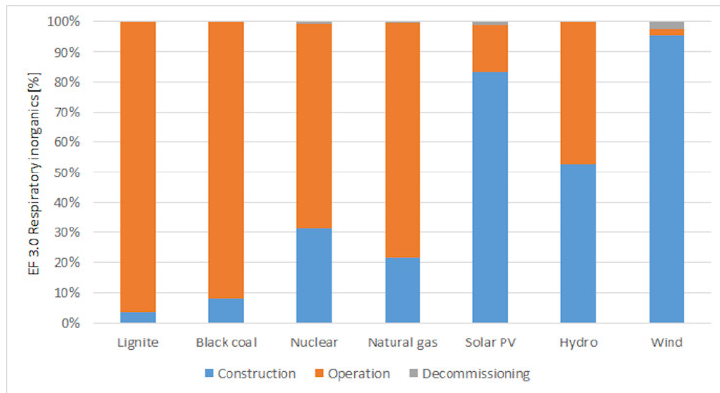
Figure 9. Contributions of the various life cycle phases (construction, operation and decommissioning) of electricity sources to the water scarcity category. Environmental benefits excluded.